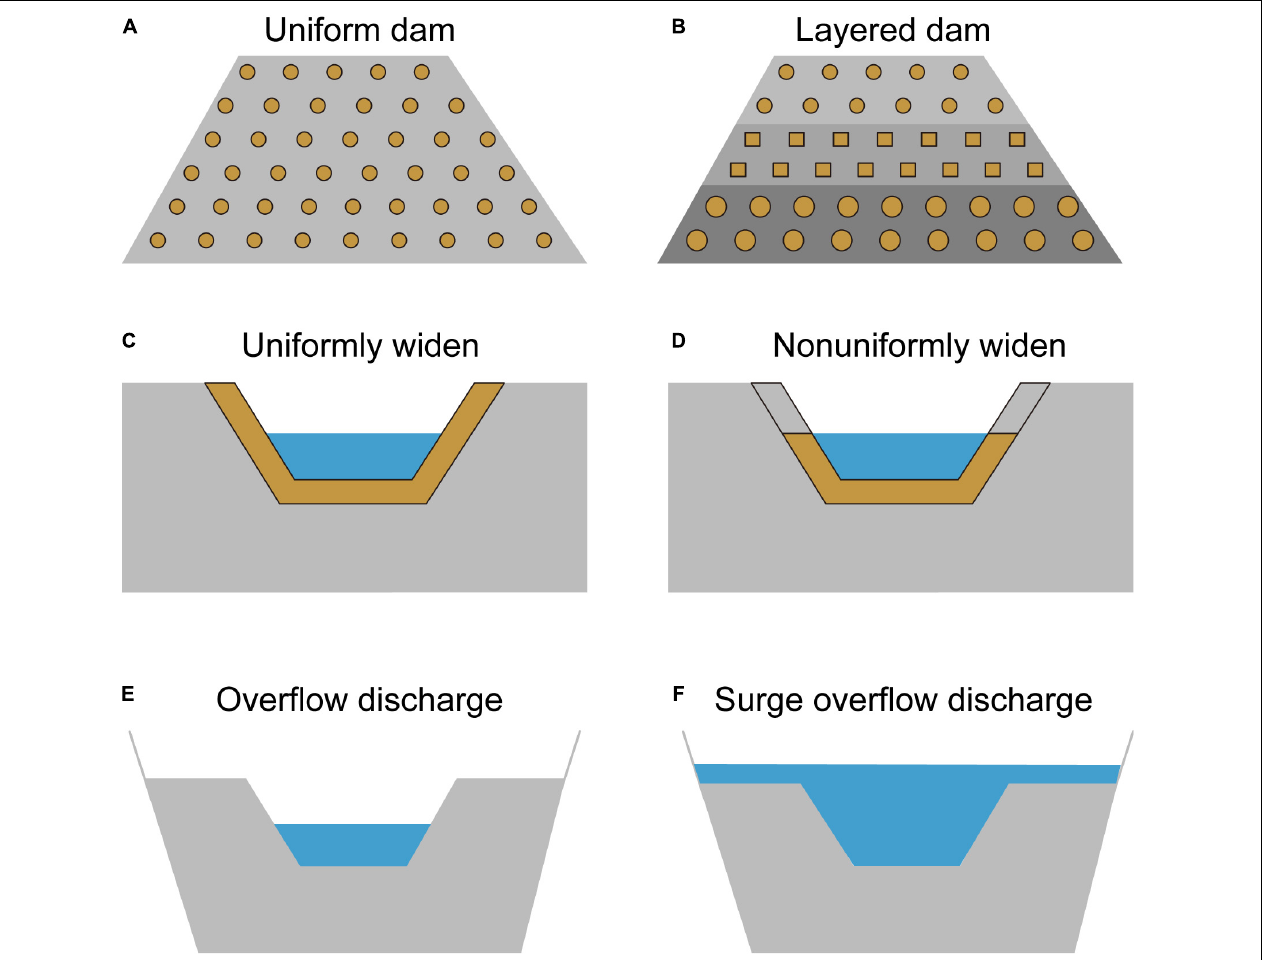
FIGURE 11 | Modifications of models of overtopping failure in a landslide dam: (A,B) uniform and layered distribution of dam materials, respectively (Chang and Zhang, 2010); (C,D) uniformly and non-uniformly widening the breach, respectively (Zhong et al., 2018); (E) outflow discharge within the breach; and (F) outside and within the breach (Wu and Li,